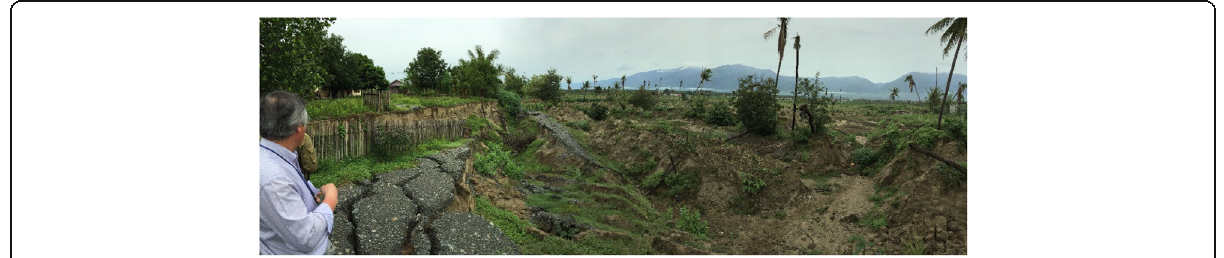
Fig. 5 Panoramic View of Upper Part of Petobo Liquefied Area